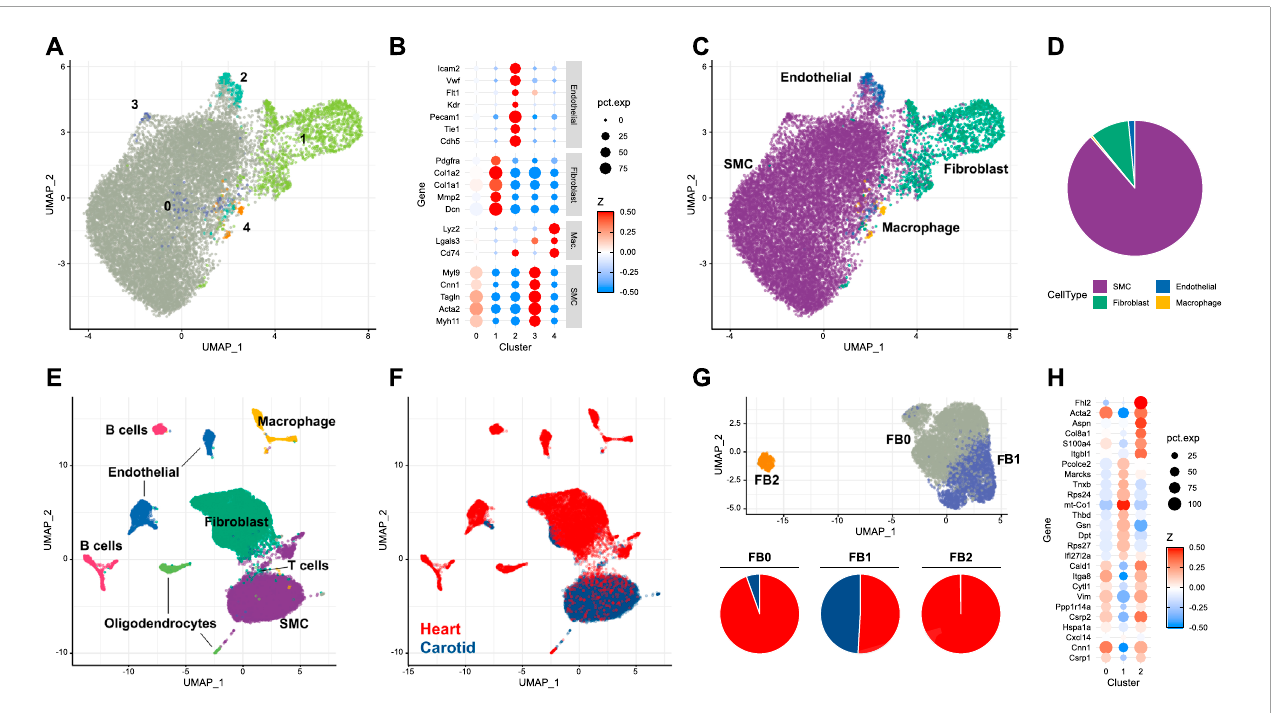
FIGURE 1 Single-cell analysis of the naive murine carotid artery (A) Uniform manifold approximation projection (UMAP) plot of cells isolated from homeostatic carotid arteries, with clusters assigned by Seurat . (B) Scaled expression of cell-type marker genes in each cell cluster. (C) UMAP plot of cells coloured by assigned cell type. (D) Proportions of cells assigned as smooth muscle cells (SMC), fibroblasts, endothelial cells and macrophages. (E, F) Integration of single-cell RNA-sequencing data from carotid and cardiac tissues. (G) Re-clustering of integrated fibroblasts, and proportions of each cluster originating from either carotid or cardiac tissue. (H) Cluster marker genes for each integrated fibroblast